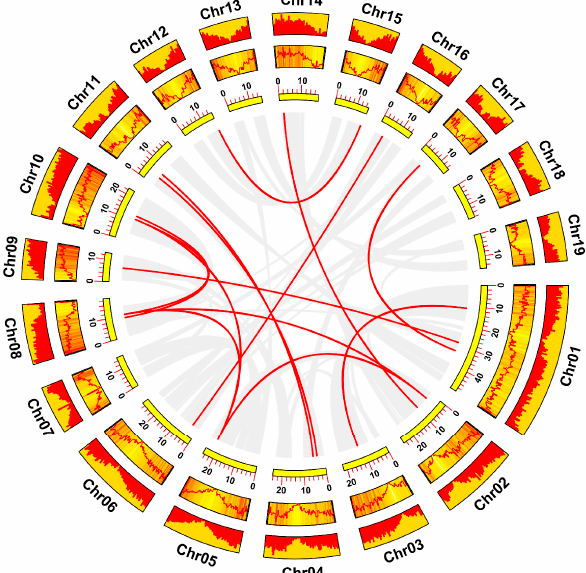
Figure 6. Collinearity analysis among poplar HSF genes. Chromosomes 01–19 of poplar are repre- sented by yellow rectangles. The lines, heatmaps, and histograms in orange rectangles represent gene density on chromosomes. Gray lines indicate all collinearity blocks in the poplar genome, and red lines between chromosomes indicate gene pairs with segmental duplication.